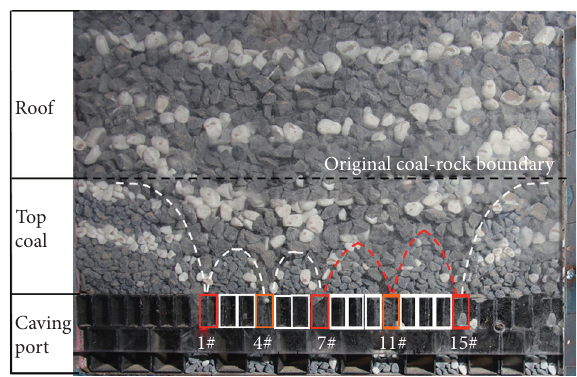
Figure 7: Coal-rock settlement curves for the two coal caving schemes (4# and 11#).